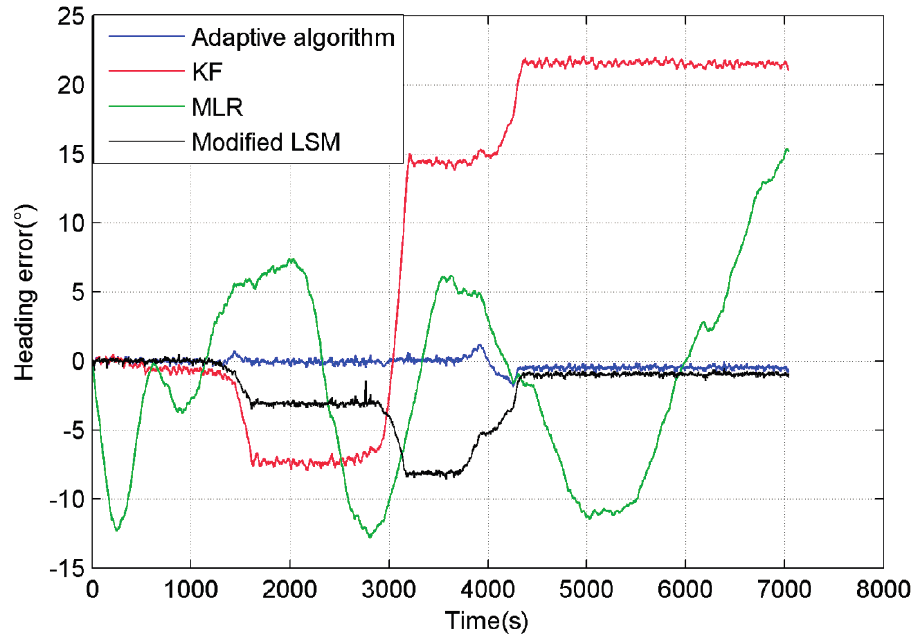
Figure 5. Heading error of different algorithms with